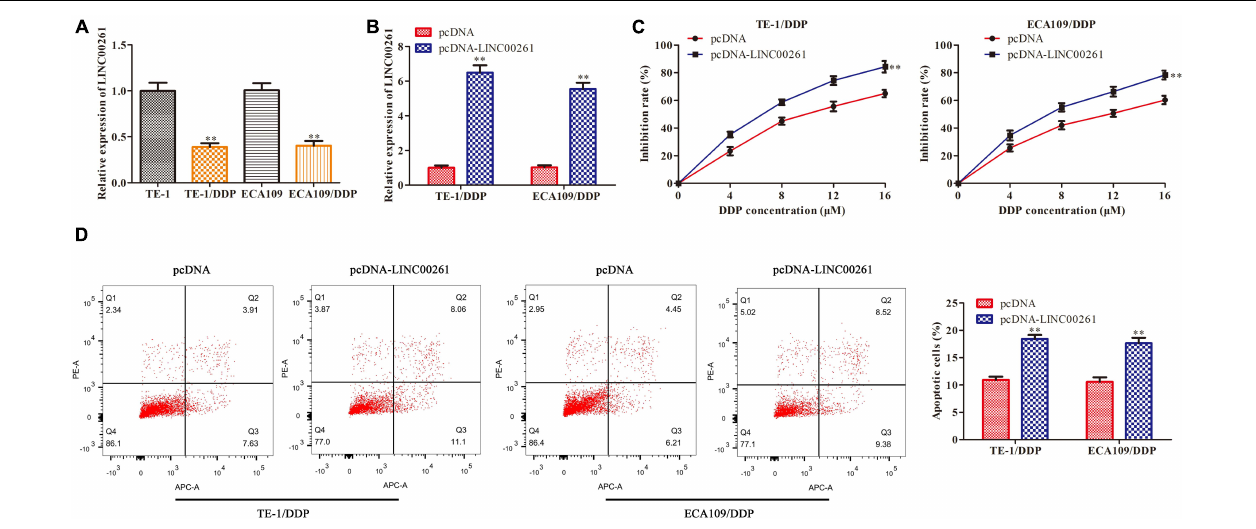
FIGURE 3 | Overexpression of LINC00261 suppresses DDP resistance in ESCC cells. We constructed the DDP-resistant cells line (TE-1/DPP and ECA109/DDP). TE-1/DPP and ECA109/DDP were transfected with pcDNA-LINC00261 and pcDNA. (A) The expression of LINC00261 in TE-1, TE-1/DPP, ECA109, and